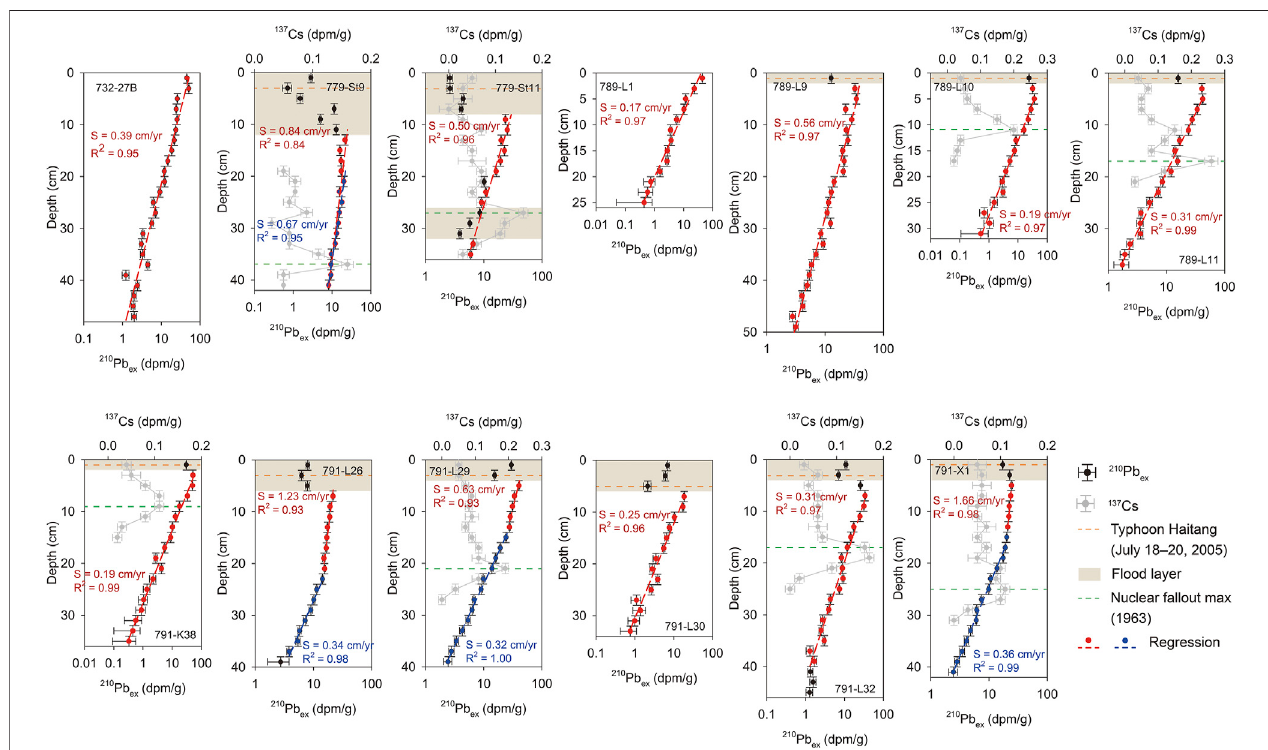
FIGURE 2 | The 210 Pb ex pro fi le in each sediment core (black dots) shows a good fi t ( R 2 > 0.93) with a steady-state advection-decay model. The red and blue dots represent the selected fi tting points, and the dashed line of each color represents the corresponding fi tting results. The black dots that are not marked by color are not included in the fi t, usually in the fl ood event layer. The 137 Cs pro fi le is represented by gray dots. The control points in the age model, the maximum value of 137 Cs and Typhoon Haitang, are represented by green and orange dashed lines, respectively [The data of 210 Pb ex and 137 Cs was from Huh et al., (2009)]. Brown patches in the core top indicate the event layer ( fl ood